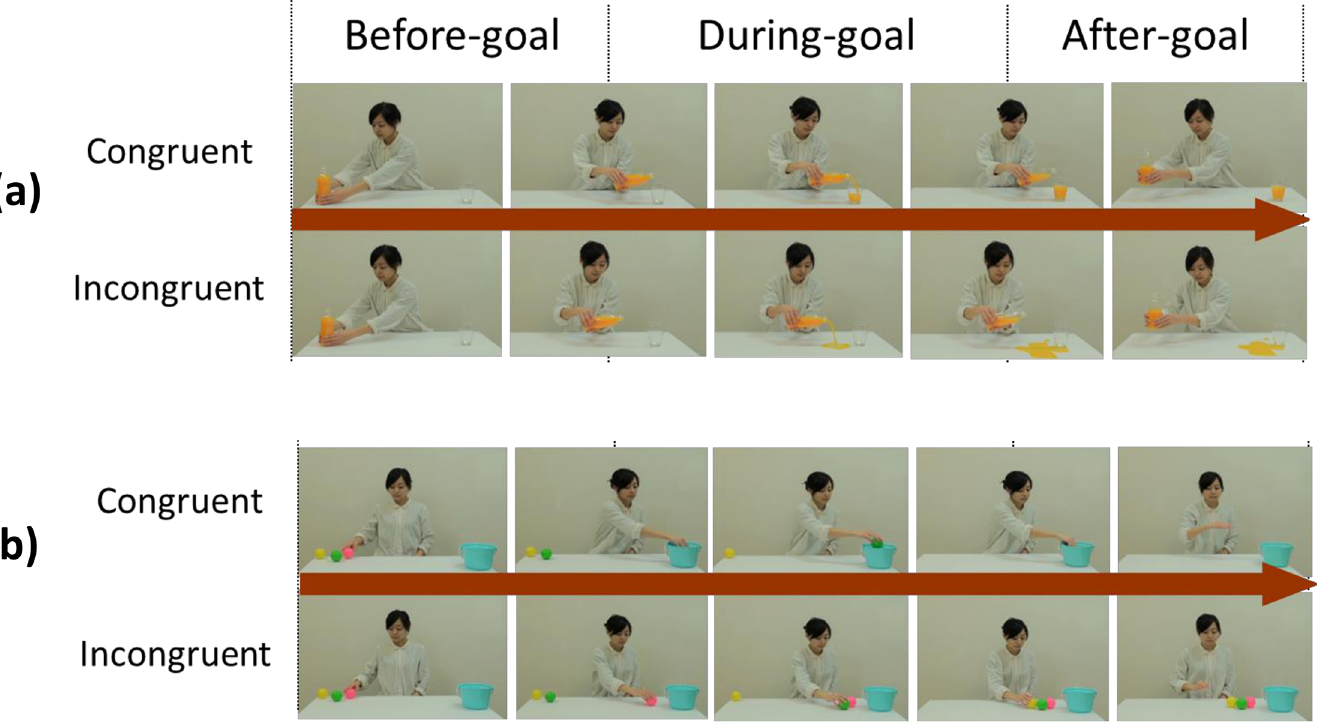
Fig 2. (a) Experiments 1 and 3: A female human adult actor sits in front of a table and pours juice from a bottle into a clear glass cup (congruent action, upper) or pours juice onto the table top (incongruent action, below). (b) Experiment 2: A female human adult actor sits at a table and places balls into a container (congruent action, upper) or places balls on the table top (incongruent action, below). These video stimuli were divided into the three phases of before, during, and after goal achievement. The before-goal phase began with the frame in which the manipulation of the object began and concluded with the frame depicting the onset of pouring juice or transporting the first grasped ball. The during-goal phase began with the frame depicting the onset of pouring or transporting and concluded with the frame depicting the end of the pouring or transporting action. The after-goal phase began with the frame depicting the end of the pouring or transporting action and concluded with the frame showing that the actor ’ s hand had returned to the location where the manipulation of the object